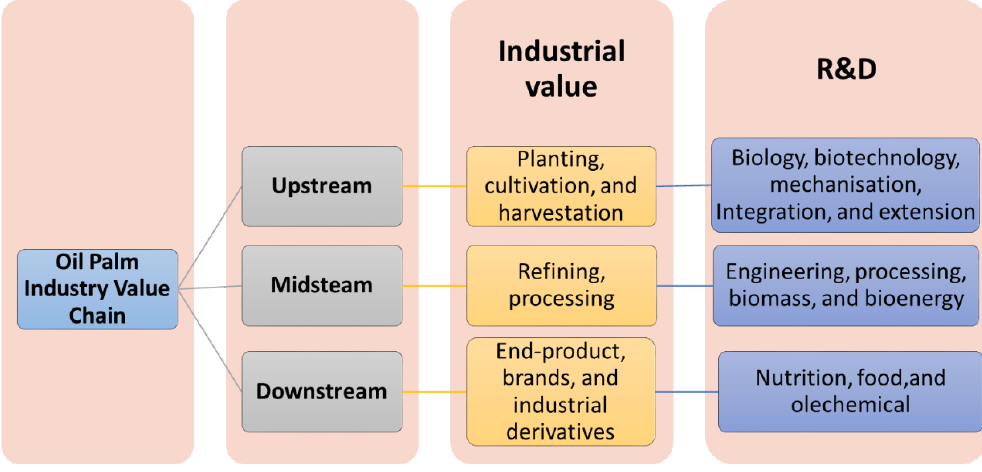
Figure 1. Industrial value chain in oil palm cultivation.